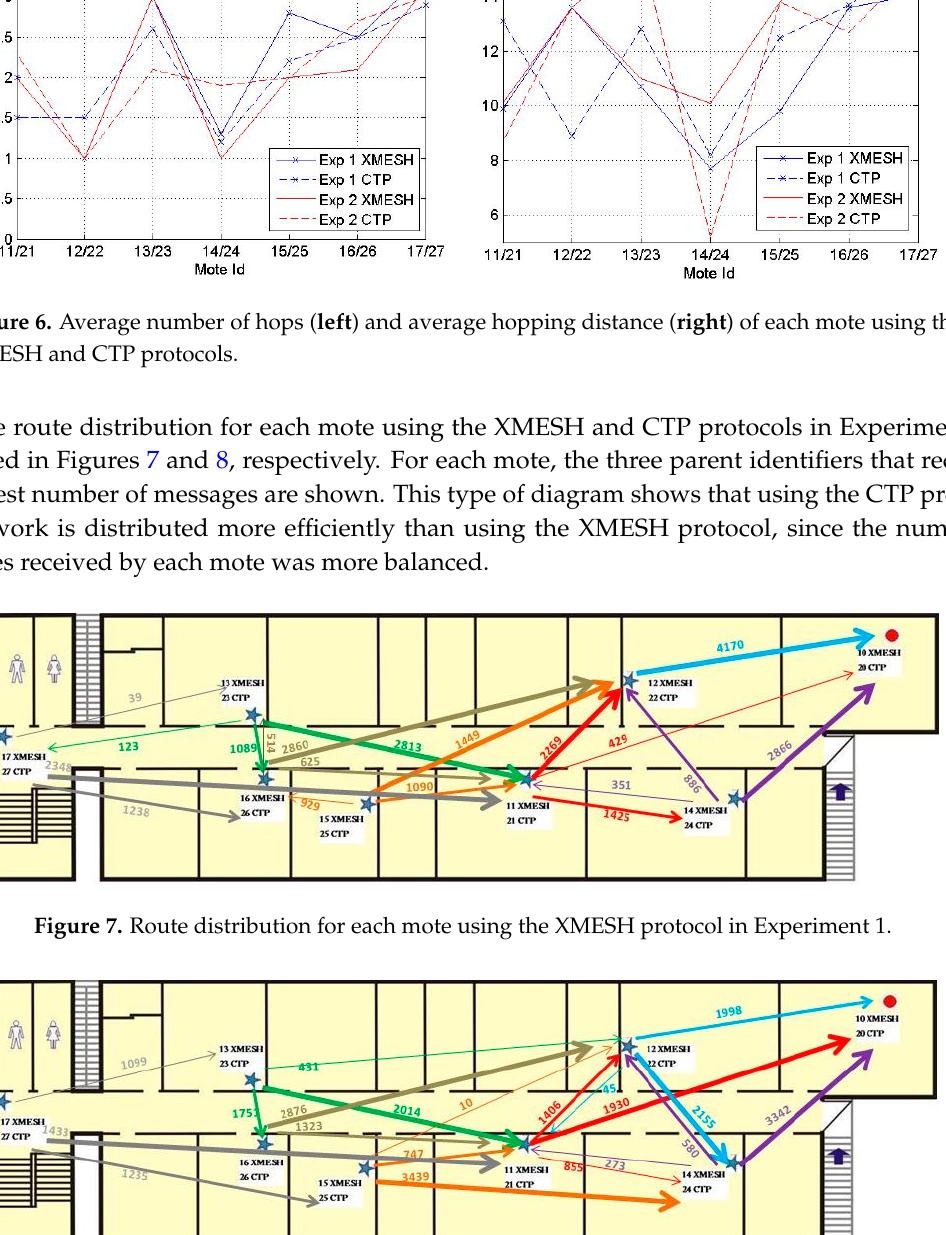
Figure 8. Route distribution for each mote using the CTP protocol in Experiment 1.